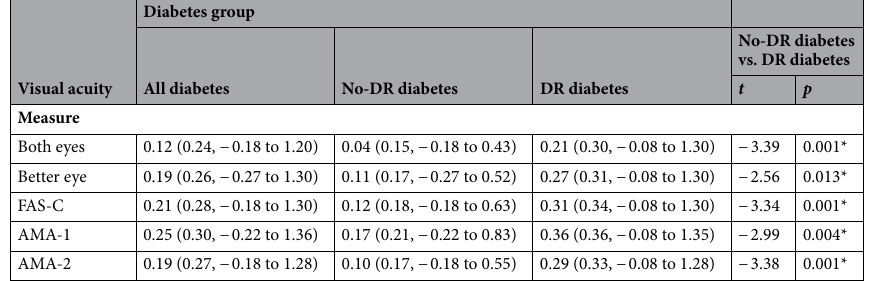
Table 2. Visual acuity (logMAR) of all patients with T2DM, patients with T2DM without DR, and patients with T2DM with DR. Values are shown as mean (SD, range). DR diabetic retinopathy, FVS‑C functional acuity score according to the algorithm developed by Colenbrander, AMA American Medical Association. The p values are based on the independent two-sample t -test analysis to examine the difference between patients with T2DM with DR and those without DR. * indicates significant p values ( p <